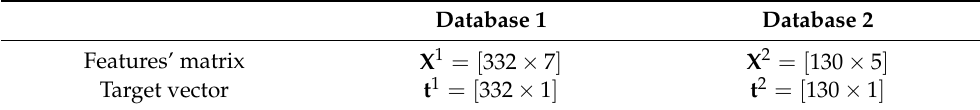
Table 2. Overview of the two databases 1